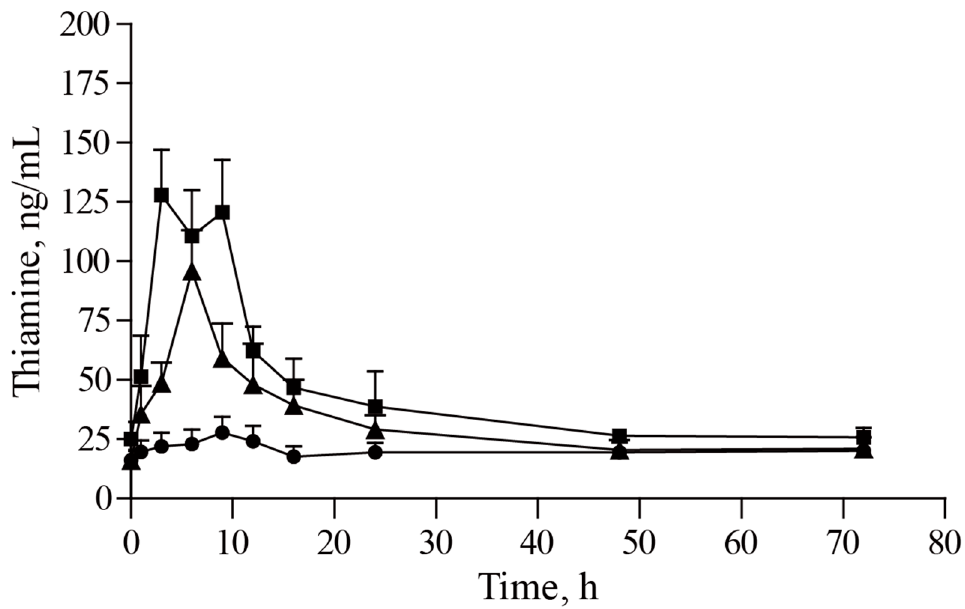
Figure 5. The plasma concentration of thiamine versus time. The concentration of thiamine in plasma from 0 to 72 h after oral placebo ( ● ), non-microencapsulated vitamin supplement ( ▪ ), and microencapsulated vitamin supplement ( ▲ ), respectively. Error bars represent standard deviations.